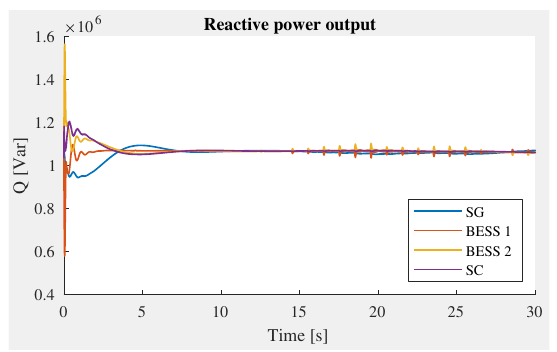
Figure 18. Reactive power